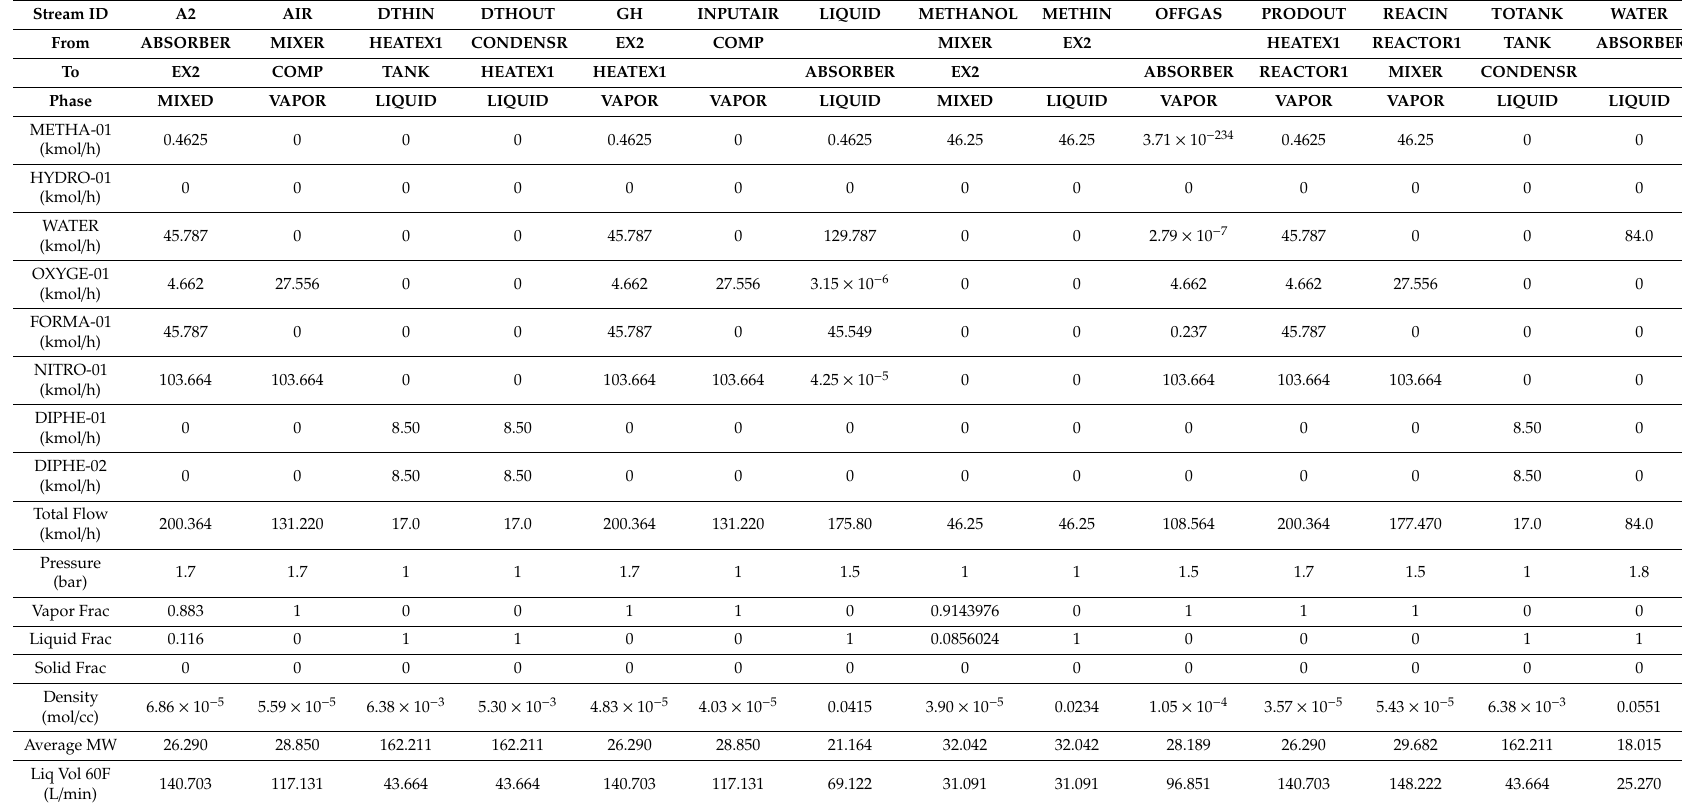
Table 2. Material balance of Molybdenum-based